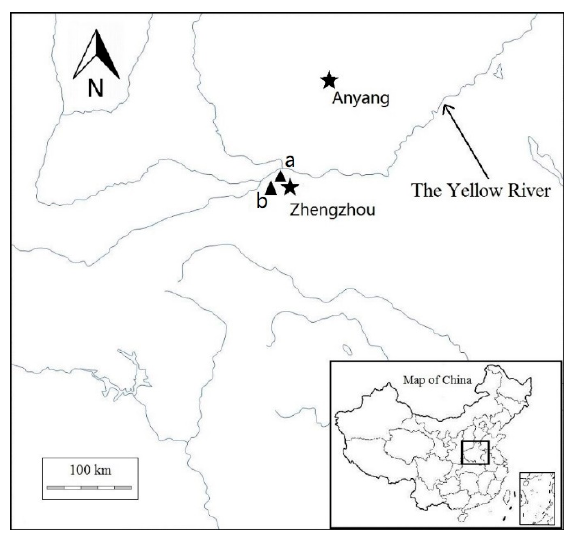
Figure 2. Map of China showing the location of the ( a ) Xiaohucun site and ( b ) Guandimiao site. Note: Zhengzhou is the capital of Henan Province.